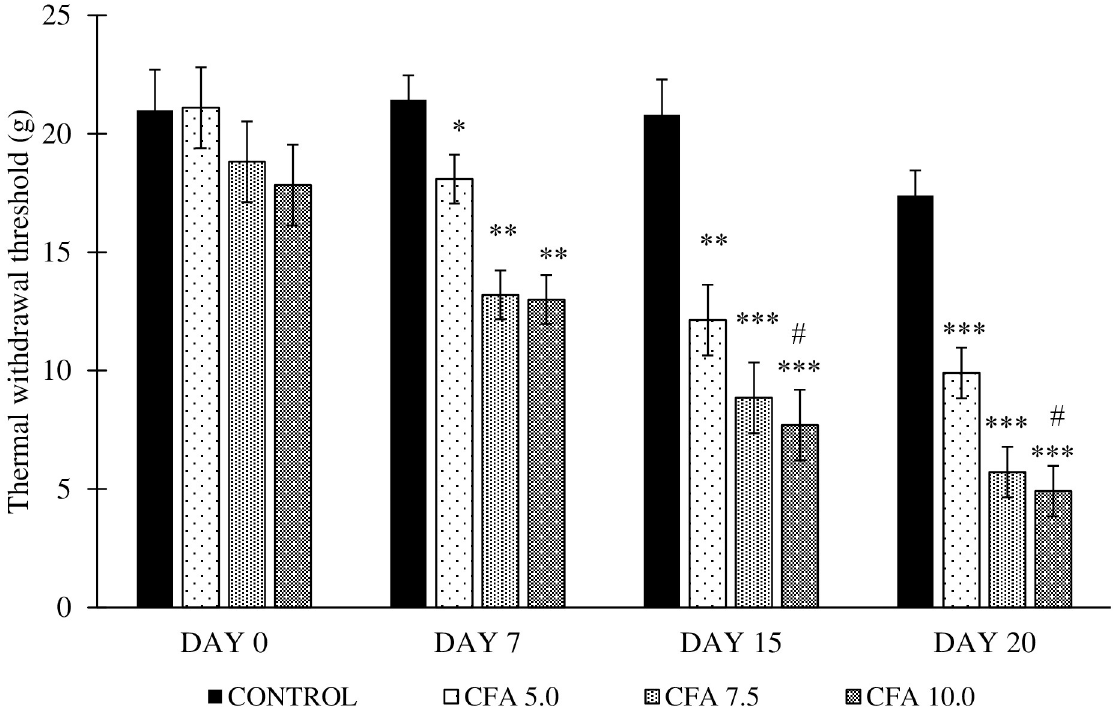
Fig 5. Thermal withdrawal threshold in the treatment groups on day 0, 7, 15 and 20 (n = 6). The values were expressed as mean ± standard error of the mean (SEM). � p < 0.05, �� p < 0.01 and ��� p < 0.001 Significant comparison to control group. #p < 0.05 Significant comparison to CFA 5.0 group. CFA 10.0 group demonstrated a significant gradual reduction in thermal withdrawal threshold, indicating the gradual development of thermal hyperalgesia throughout the experiment.